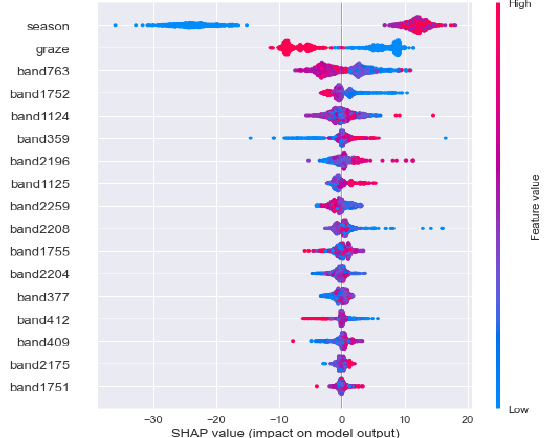
Figure 16. AGB inversion data processing